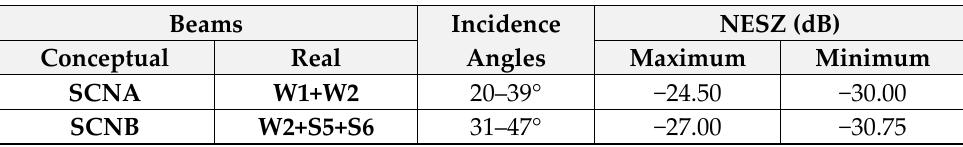
Table 8. Conceptual and real beam modes with the incidence angles, and the maximum and minimum noise floor (NESZ) for SCNA and SCNB.